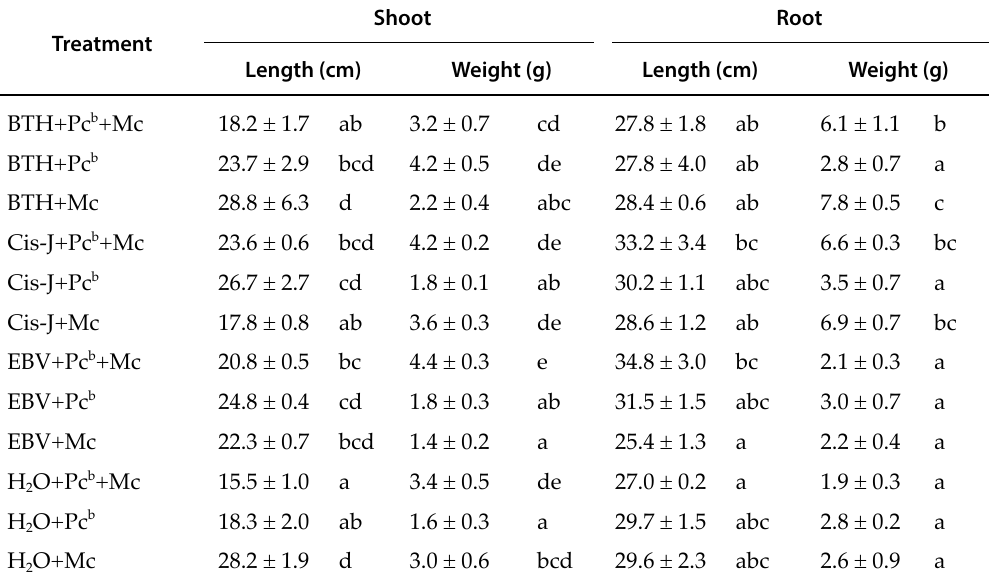
Table 1. Mean shoot and root lengths and weights of potato, Solanum tuberosum , cv. Désirée, grown in soil with Pochonia chlamydosporia (Pc), 45 d after inoculation with 300 Meloidogyne chitwoodi (Mc) second-stage juveniles, and treated with foliar sprays of: 2.5 mM benzothiadiazole (BTH); 1 mM cis- jasmone (Cis-J); 0.1% ethoxylated nonylphenol (EBV); or water (H 2 O) a